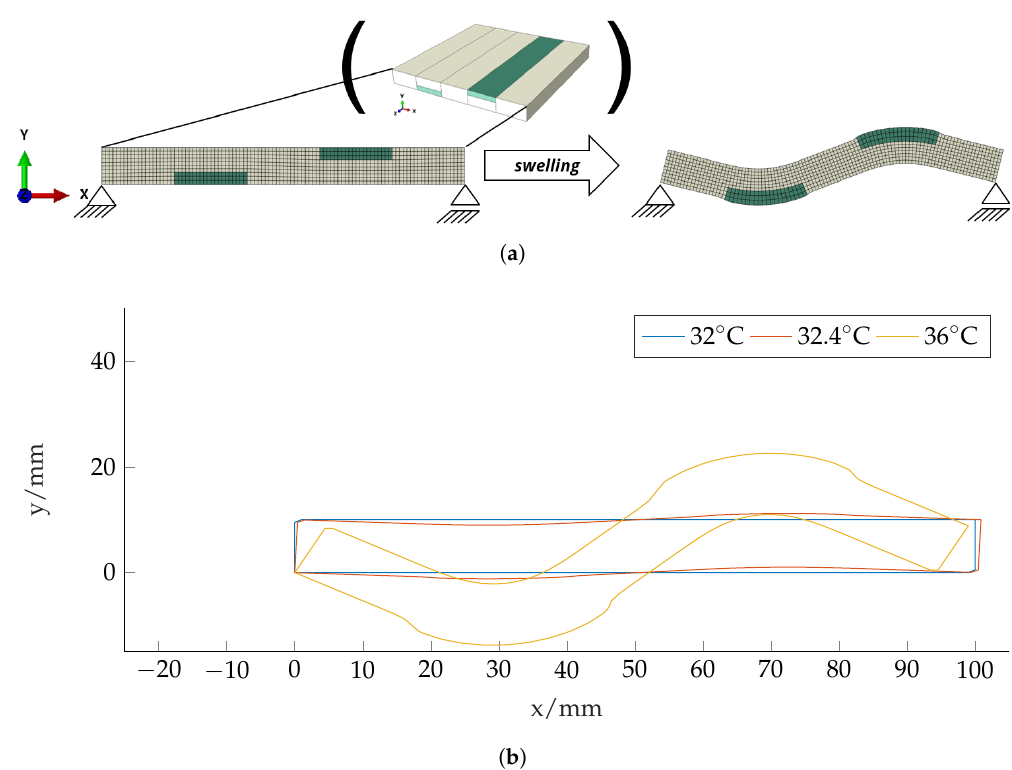
Figure 9. Basic concept and 2D simulation results for the cross-section of a beam made to form a corrugated sheet. ( a ) Two-dimensional swelling of an active–passive composite structure that represents the cross-section of a plate according to Figure 4. Under swelling, the cross-section forms a corrugated sheet-like structure. The two hydrogel patches have the dimensions 20 mm × 3.33 mm. Please note that this is a different setup in comparison to the U-forming beam structure. ( b ) Beam cross-section at different temperature states and according two-layer